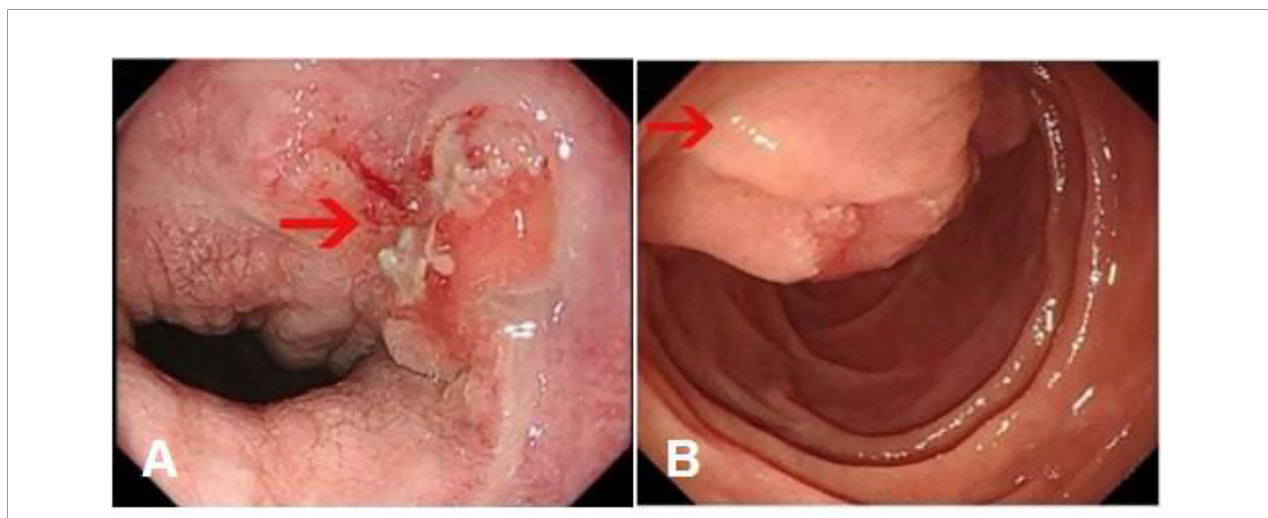
FIGURE 1 | Gastroscopy results. (A) Super fi cial ulceration at the esophagogastric junction with irregular protrusion. (Arrow: the location of the tumor) (B) A polypoidal protuberant mass in the duodenal papilla protruding into the lumen. (Arrow: the location of the